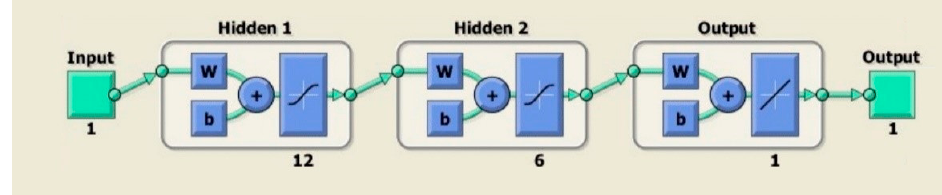
Figure 14. ANN network architecture.